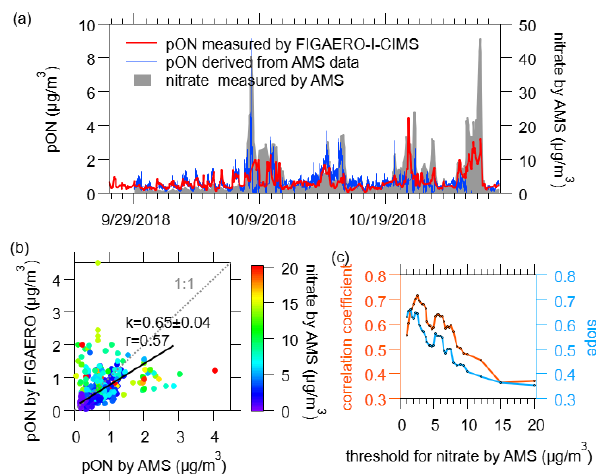
Figure 15. (a) Time series of particulate N-containing organic com- pounds measured by FIGAERO-I-CIMS (pON by FIGAERO), par- ticulate organic nitrates derived from AMS data (pON by AMS) as well as particulate inorganic nitrate. (b) Comparison of pON by FIGAERO and pON by AMS, color-coded by the concentrations of particulate inorganic nitrate measured by AMS. The black line presents the linear fit for nitrate by AMS below 8µg/m 3 . (c) The determined slopes and correlation coefficients between pON by FI- GAERO versus pON by AMS by filtering the data below different thresholds of particulate inorganic nitrate measured by AMS.